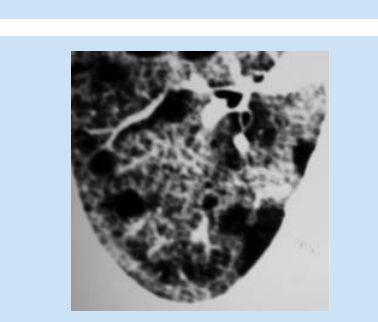
Fig. 21a. Lymphangitis carcinomatosa.